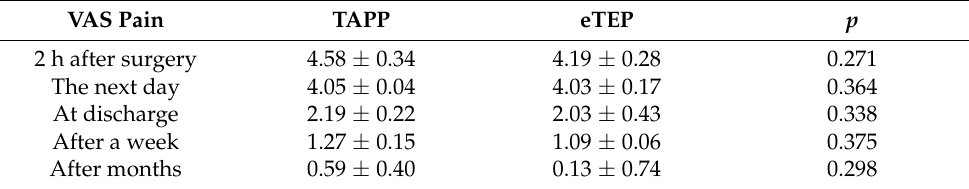
Table 3. Comparison of the results of assessing the severity of pain according to VAS.